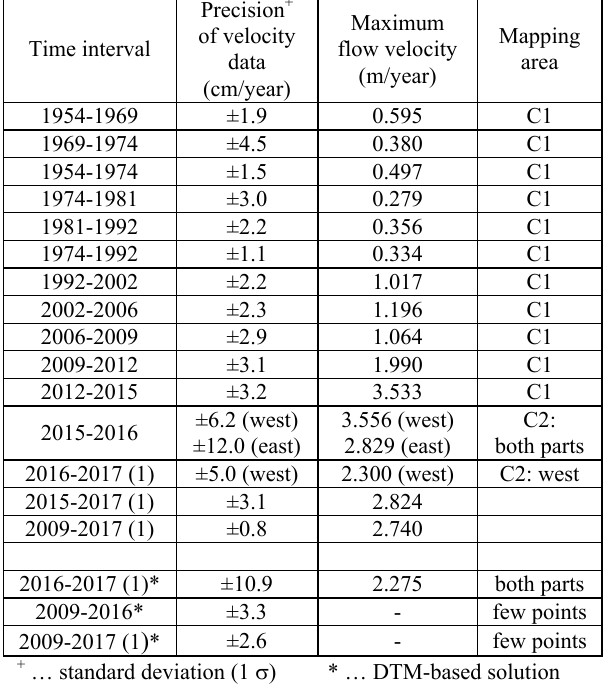
Table 7. Velocity data 1954-2017